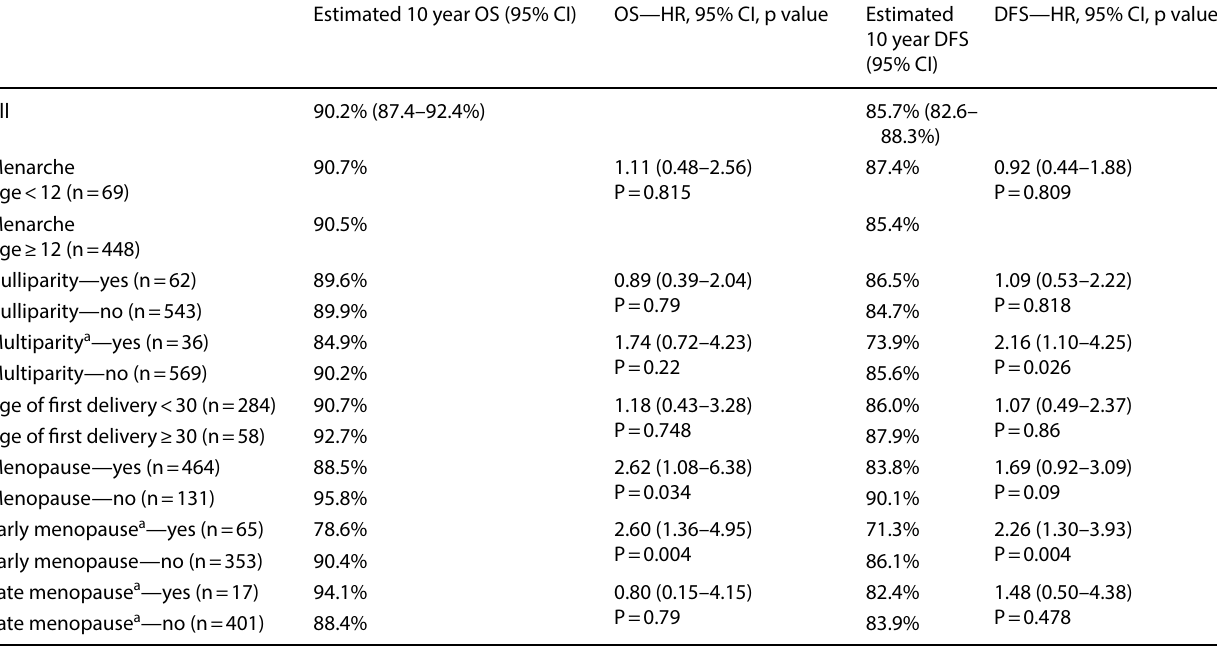
Table 2 DFS and OS and by estrogen